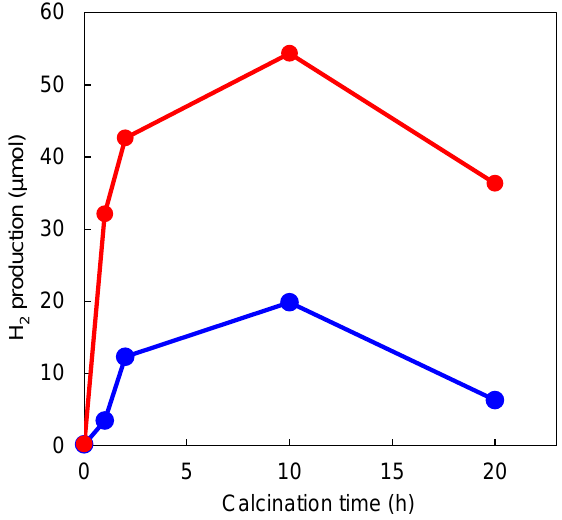
Figure 6. Effect of calcination time on photocatalytic H 2 production from formic acid with TiO 2 nanotubes with the aid of simultaneous Rh deposition. Reaction time: 3 h (blue line) and 5 h (red line); reaction temperature: 50 ◦ C: calcination temperature: 500 ◦